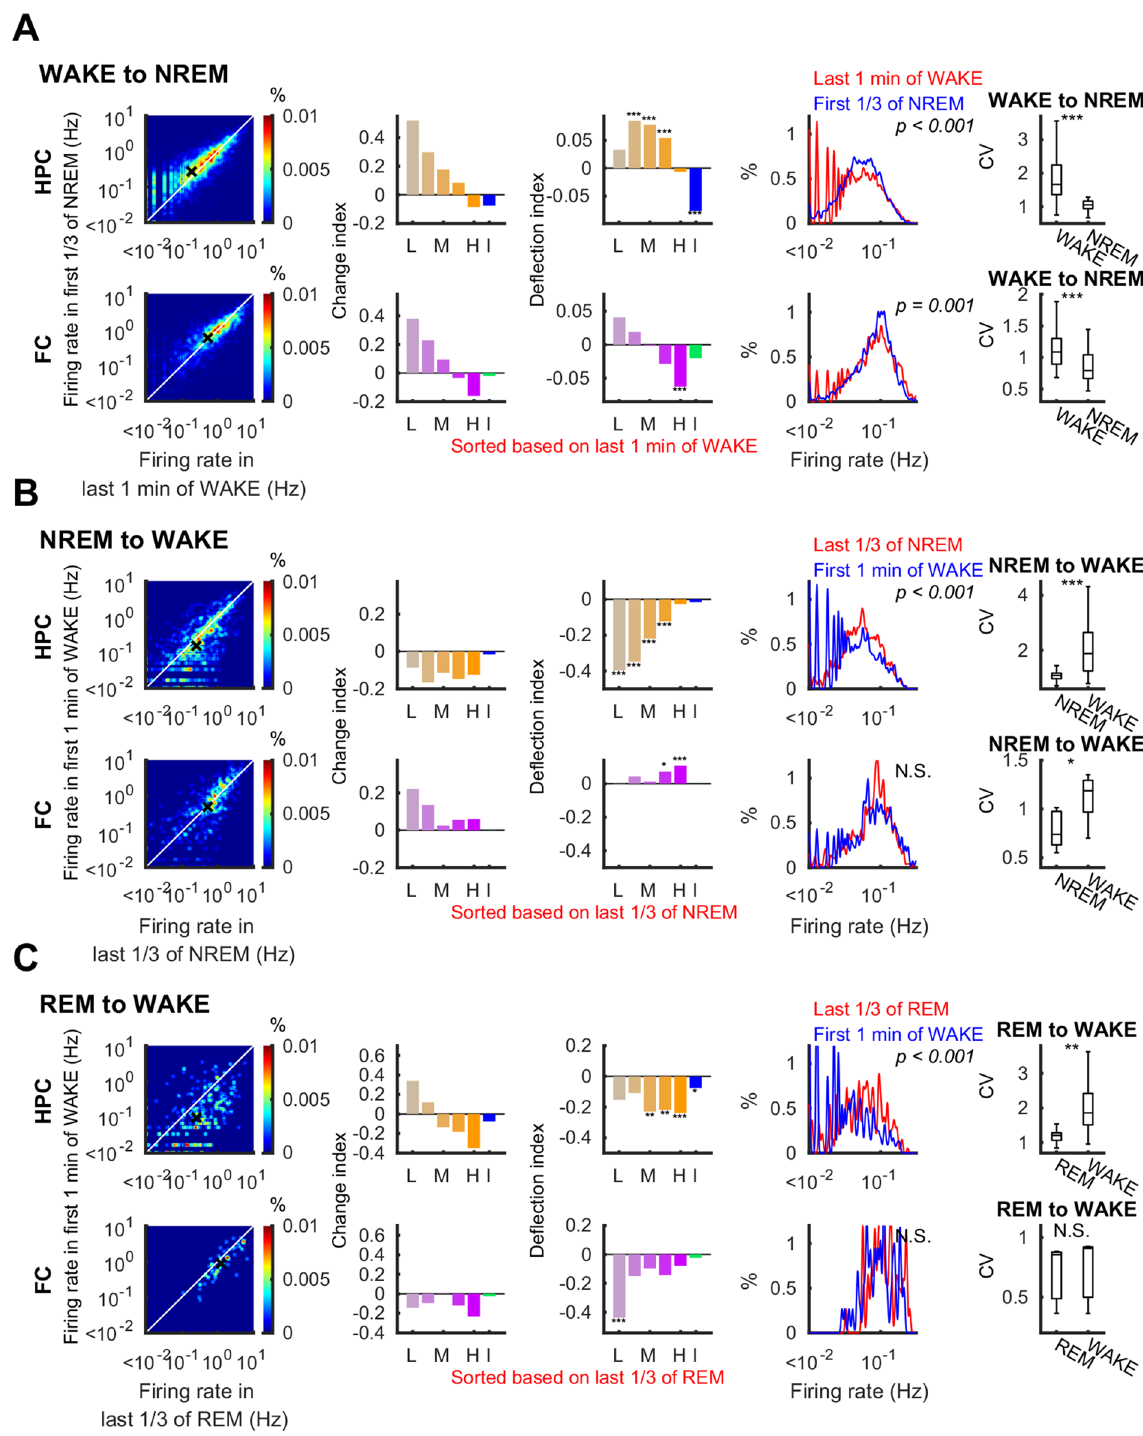
Figure 5. Firing rate changes at transitions between wake and sleep. Similar to Fig. 4, firing rates (left panels), change ( CI ) and deflection ( DI ) indices (second and third panels) with 95% confidence intervals of shuffle mean (sheds on the bars), firing rate distribution (fourth panels) and coefficient of variation of firing rates (right panels) on transition from WAKE to NREM ( A ), NREM to WAKE ( B ), and REM to WAKE ( C ). Top and bottom rows in each panel present data from the hippocampus (HPC) and the frontal cortex (FC), respectively. L: lowest quintile, M: middle quintile, H: highest quintile, I: interneurons. P-values for Kolmogorov–Smirnov tests are indicated on the panels in the fourth column, *p < 0.05, **p < 0.01, ***p <